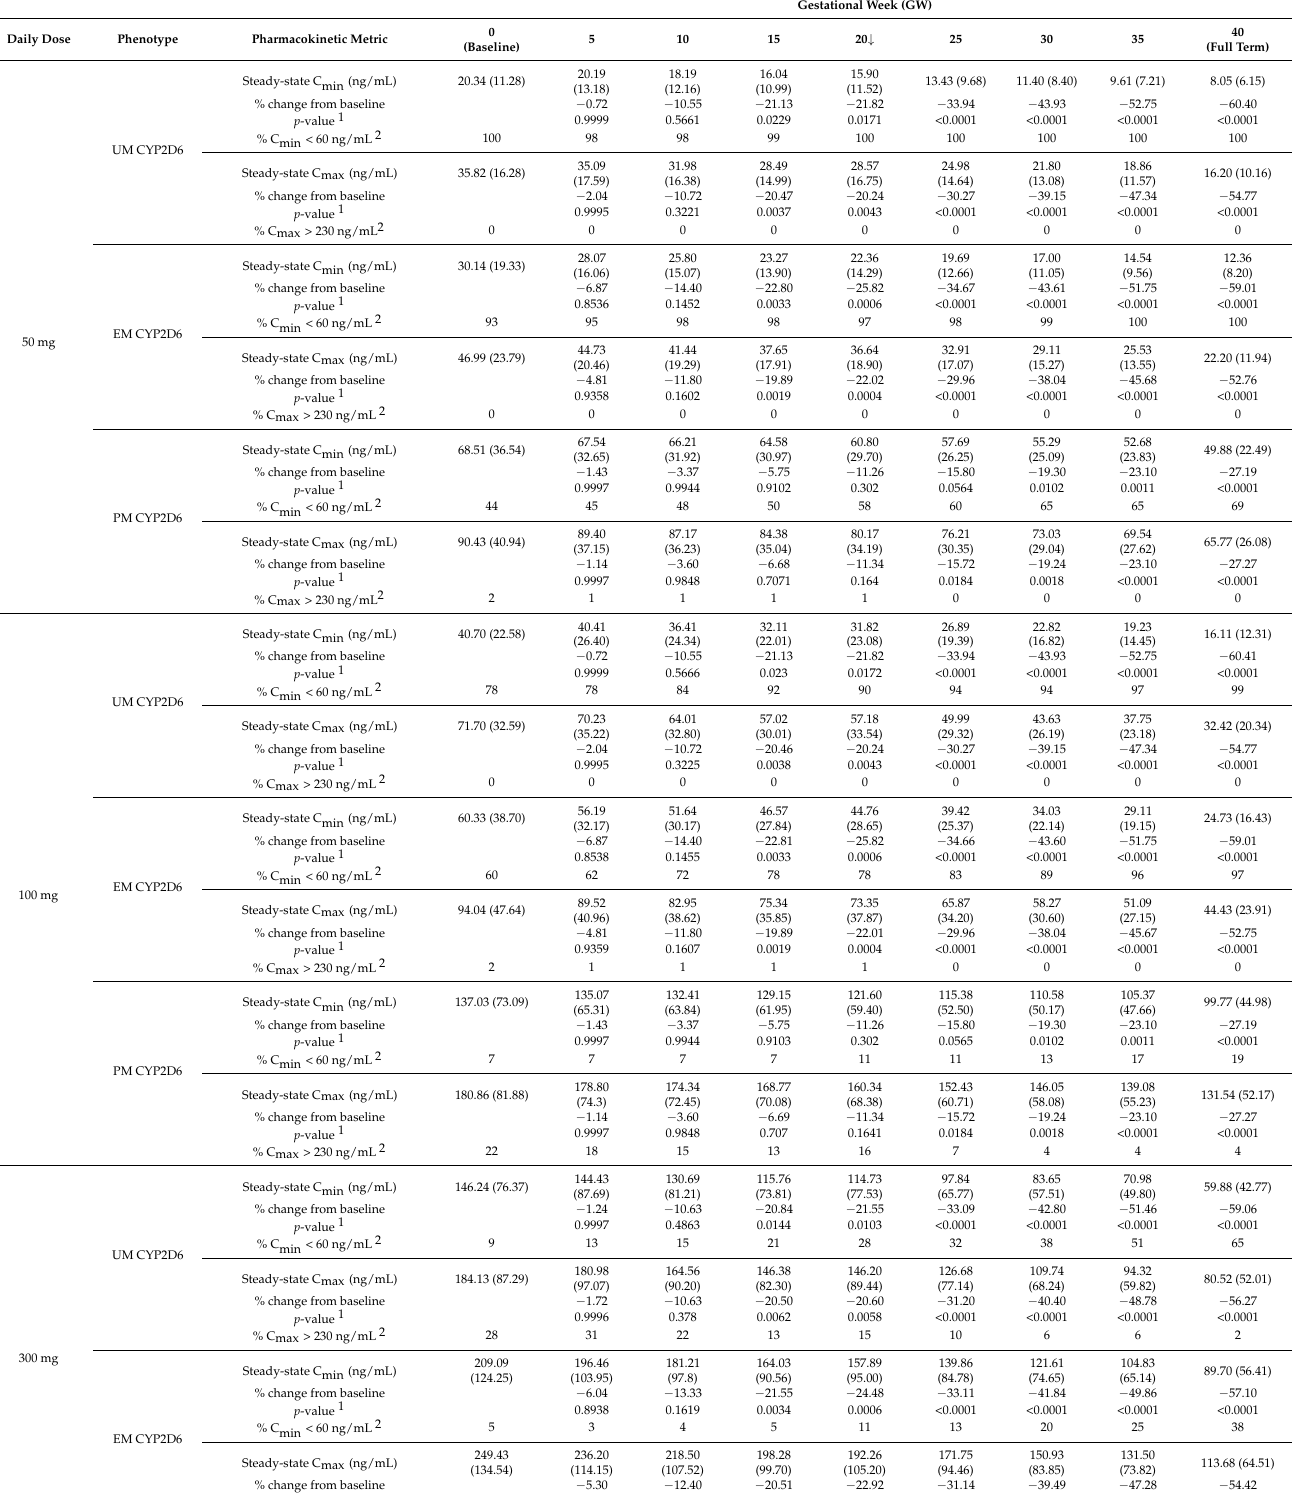
Table 5. Summary of predicted fluvoxamine plasma concentrations during